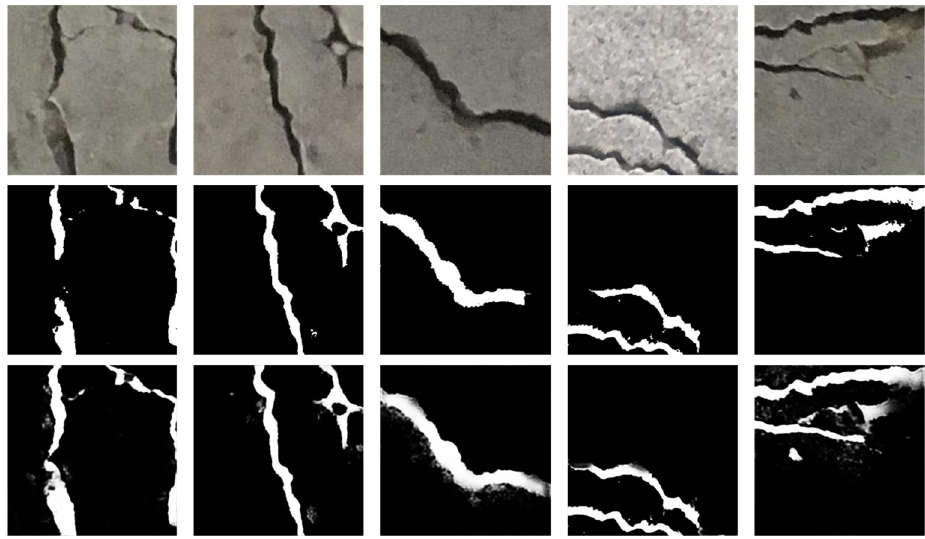
Figure 9. Five additional examples for representing the performance of our pre-trained model.